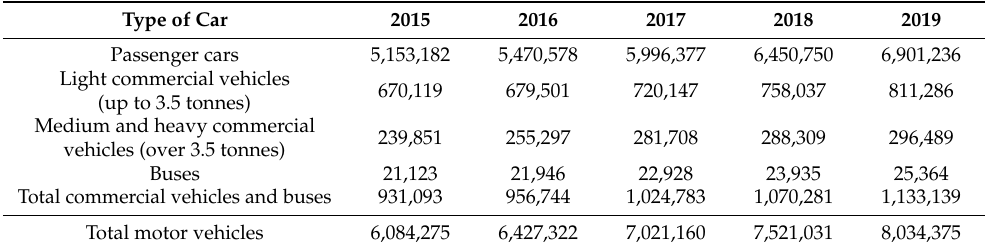
Table 4. Vehicles in use in Romania. Table made by authors with data source from ACEA [52] (data use with copyright permission).